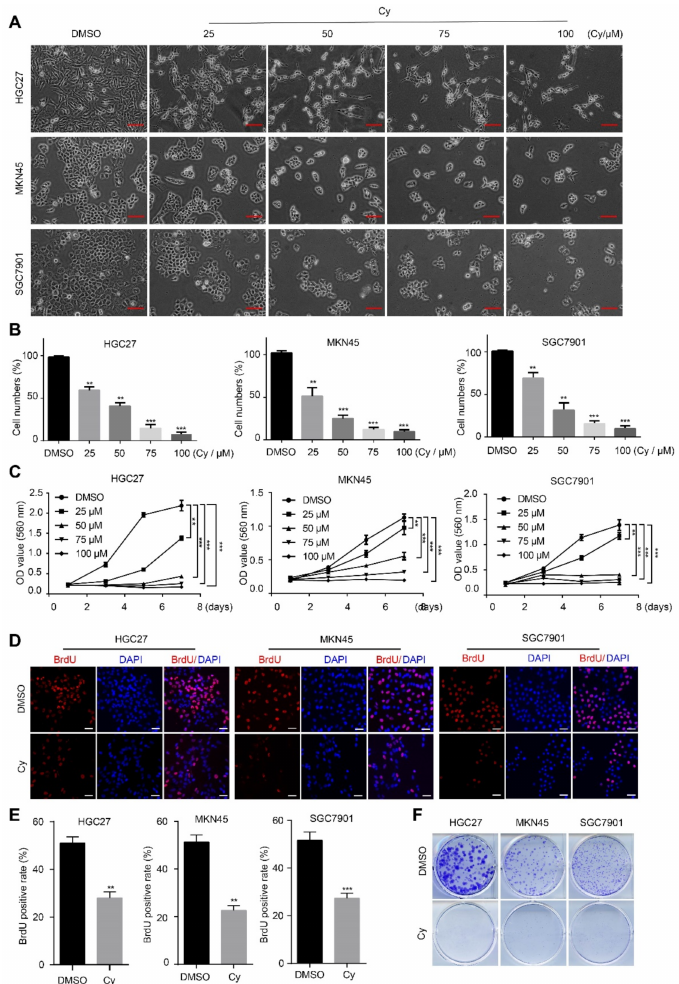
Figure 1. Cynaroside inhibits the growth of gastric cells. ( A ) Phenotypes of HGC27, MKN45 and SGC7901 cells treated with different concentrations of Cy for 48 h. DMSO was added as a control, and the scale was 100 µ m. ( B ) The percentage of cells in each group, with the percentage of cells in